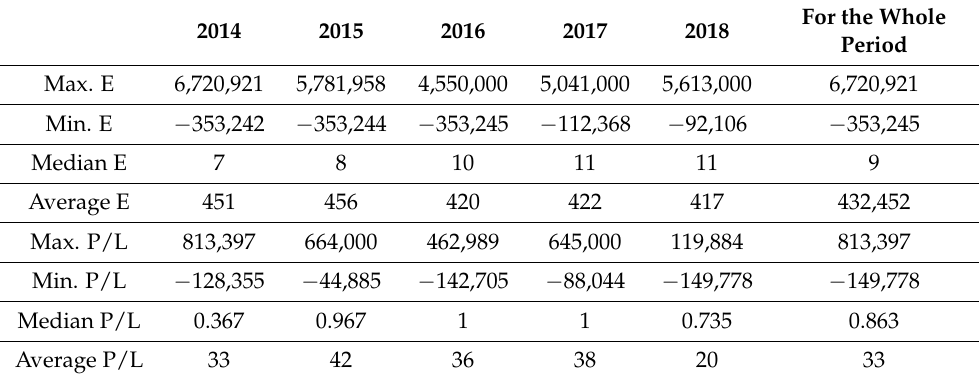
Table 1. Descriptive statistics of a sample of businesses according to the amount of equity (E) and profit or loss after tax (P/L) in (cid:48) 000 €